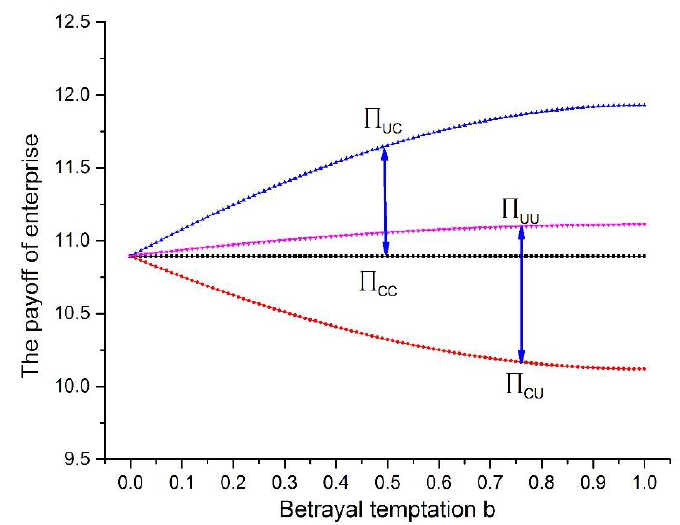
Figure 2. The payoff of enterprise under different strategy selection and betrayal temptation. Figure 2. The payo ff of enterprise under di ff erent strategy selection and betrayal